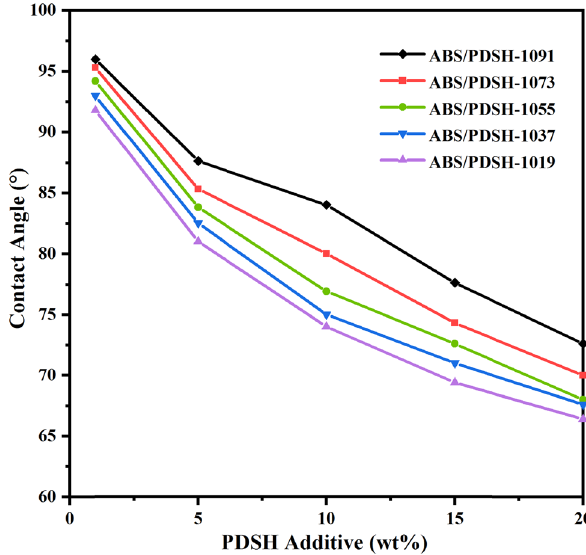
Figure 7: Contact angle values of ABS/PDSH composites as a func - tion of the antistatic agent content ( wt% ) .